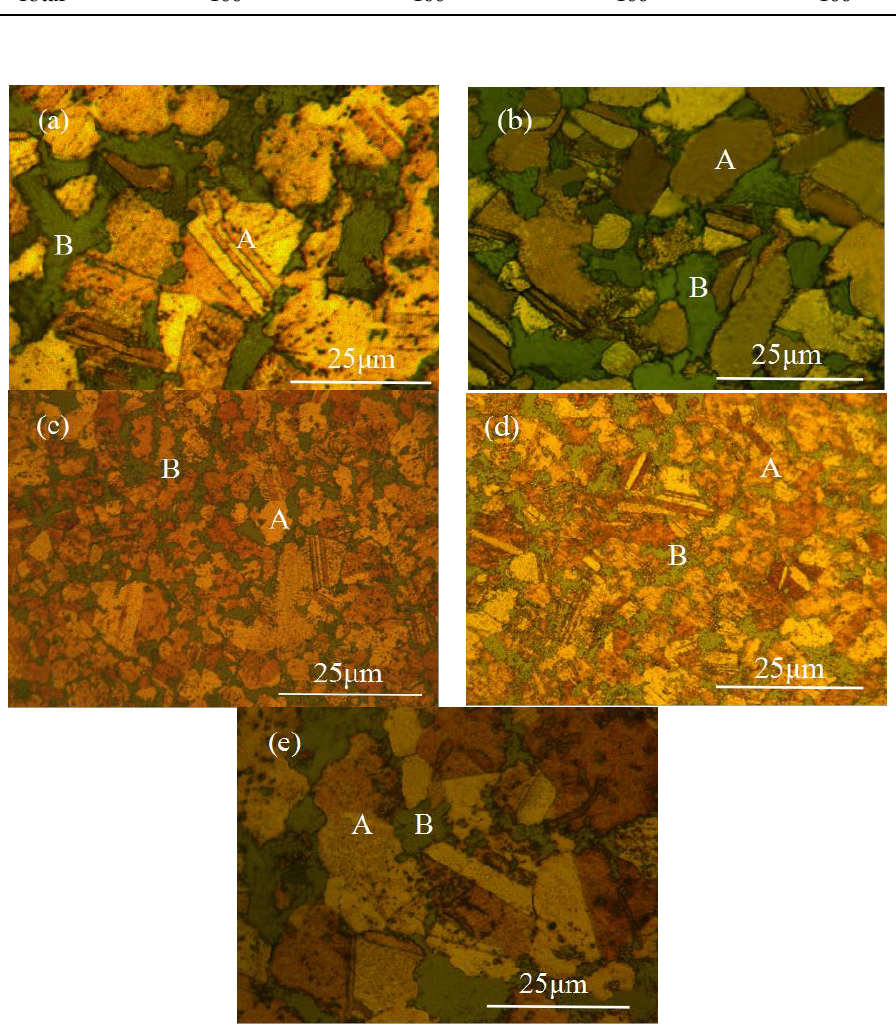
Figure 7. Effects of Ce content on microstructure of milled Cu-based alloy with different content Ce ( a ) 0 wt %; ( b ) 0.25 wt %; ( c ) 0.5 wt %; ( d ) 0.75 wt %; ( e ) 1.0 wt